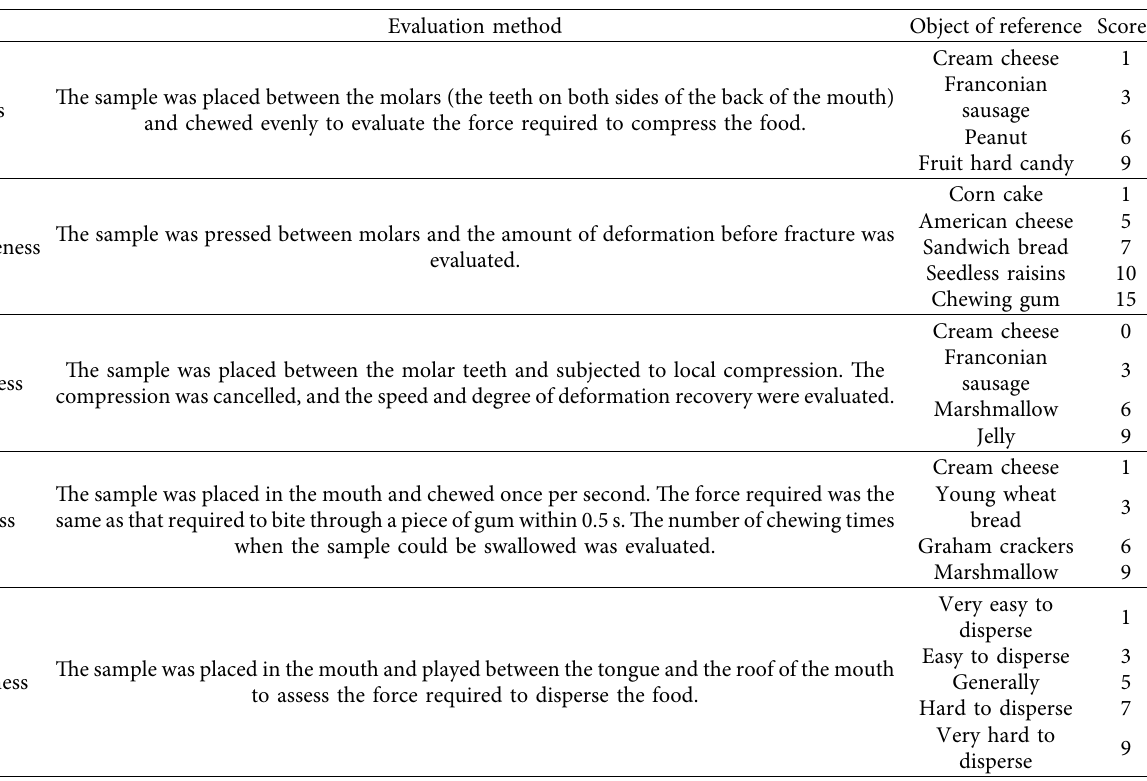
Table 1: Definition and evaluation criteria of the indexes in sensory evaluation.